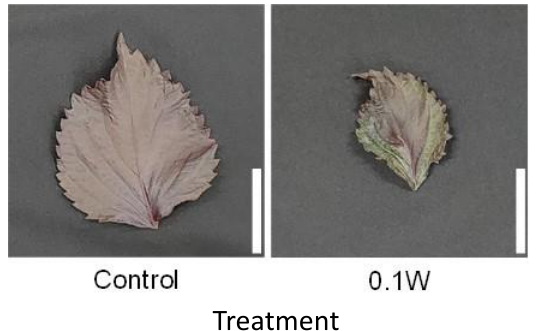
Figure 2. Appearance of a red perilla leaf at the 5th nodes counted from the bottom of the main stem 2 weeks after treatment initiation (Experiment 1). Perilla plants were irradiated for 6 h from 23:00 to 05:00 h in a UV-B light treatment regimen. The UV-B radiation intensity at the top of the plant canopy was set to 0.1 W m −2 . The integrated UV-B energy at 0.1 W m −2 was 2.2 kJ m −2 day −1 . Leaves at the 5th node counted from the bottom of the main stem were harvested 2 weeks after treatment initiation. Leaf blade length under control and under 0.1 W m −2 treatment conditions were 11.0 ± 0.7 and 7.9 ± 0.8 cm, respectively (mean ± SE, n = 6). Each white bar indicates 5 cm.